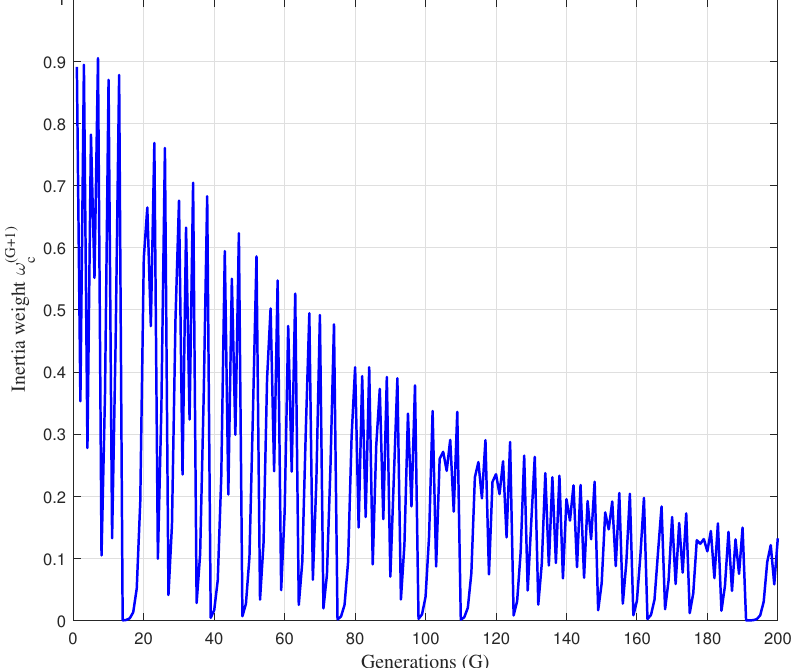
( G + 1 ) c during the search